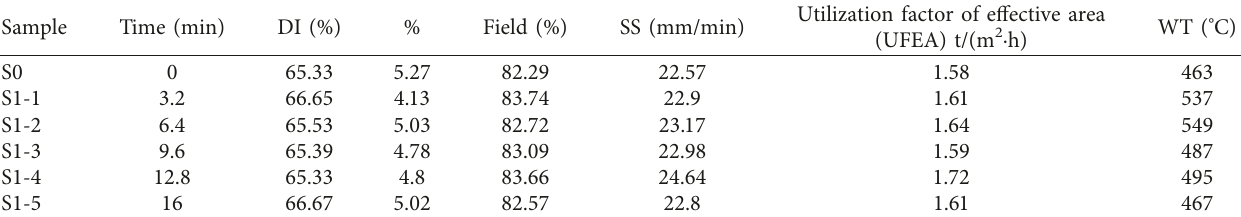
Figure 2: Schematic diagram of the sintering pot device and oxygen enrichment Table 5: Technical indices of the sintering process for different oxygen enrichment times.